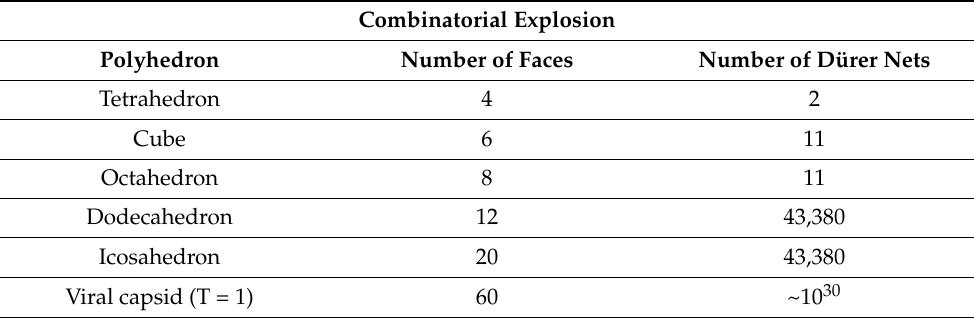
Table 2. Combinatorial Explosion of the number of Dürer nets for various polyhedra.